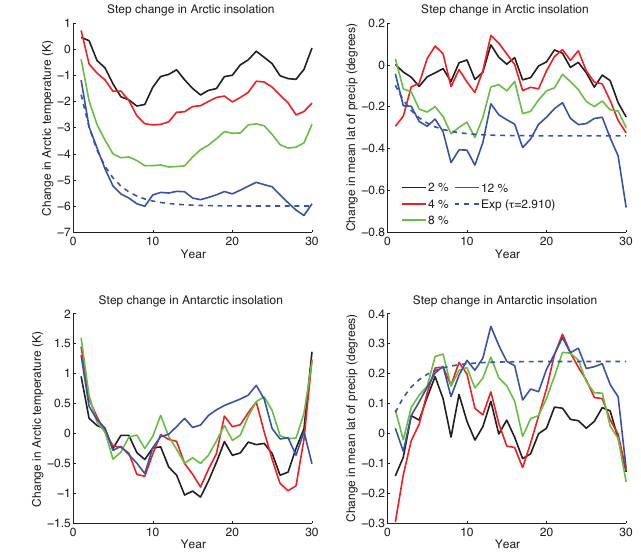
Figure 8. Step responses for the 2 × 2 design case. Step pertur- bations in the Arctic (top row panels) and Antarctic (bottom row panels) were 2, 4, 8, and 12% of total solar irradiance in those re- gions. Performing a best fit with an exponential function (Eq. 6) to the 12% step-response results yields β = 0.5 and τ = 2.410, plus a half year of time delay due to annual averaging.